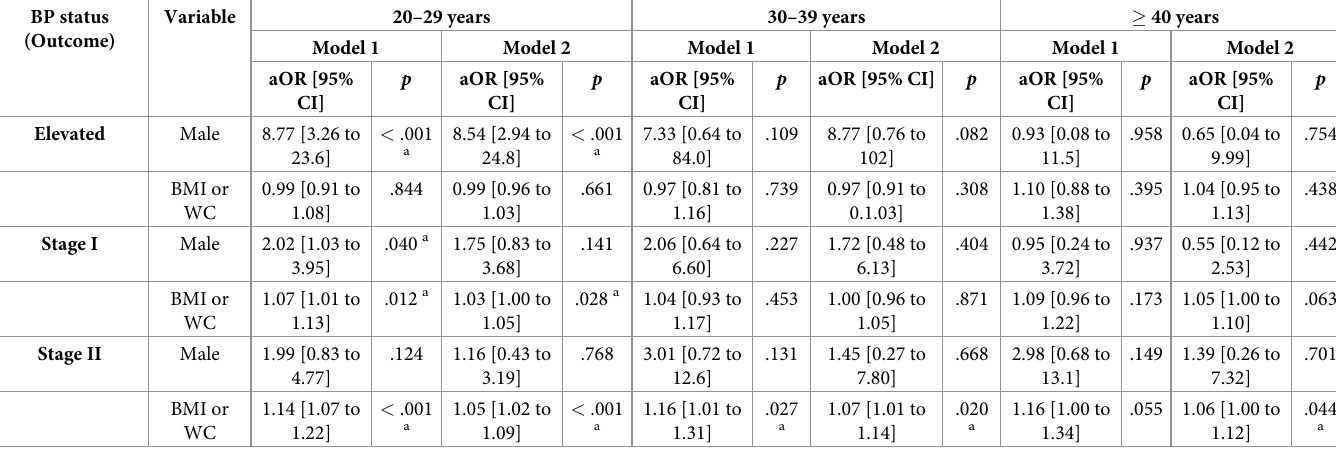
Table 4. Multinomial regression analyses of the associations of sex and anthropometric measurements with blood pressure status satisfied by age group (n = 489). BP status